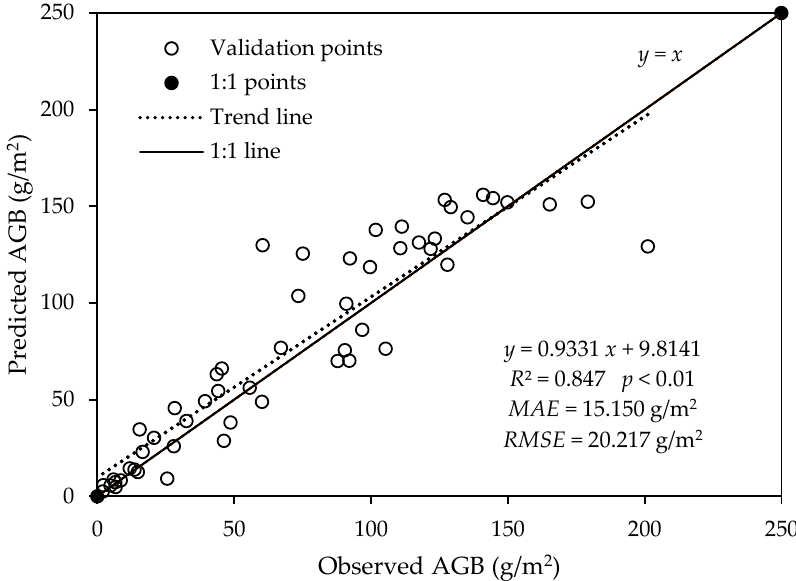
Figure 9. Correlation between observed and UAV predicted AGB.